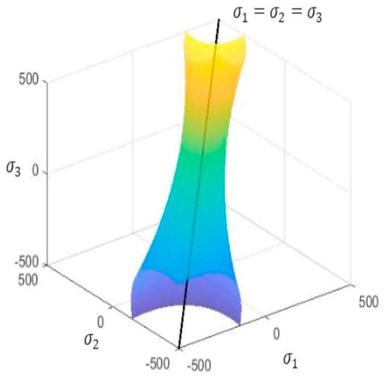
Yield surface reconstructed based on the inversely identified parameters.